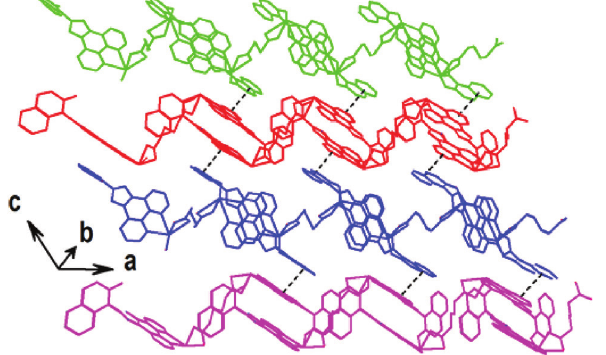
Figure 3: View of the two-dimensional supramolecular layer structure of 1 formed by π-π interactions.